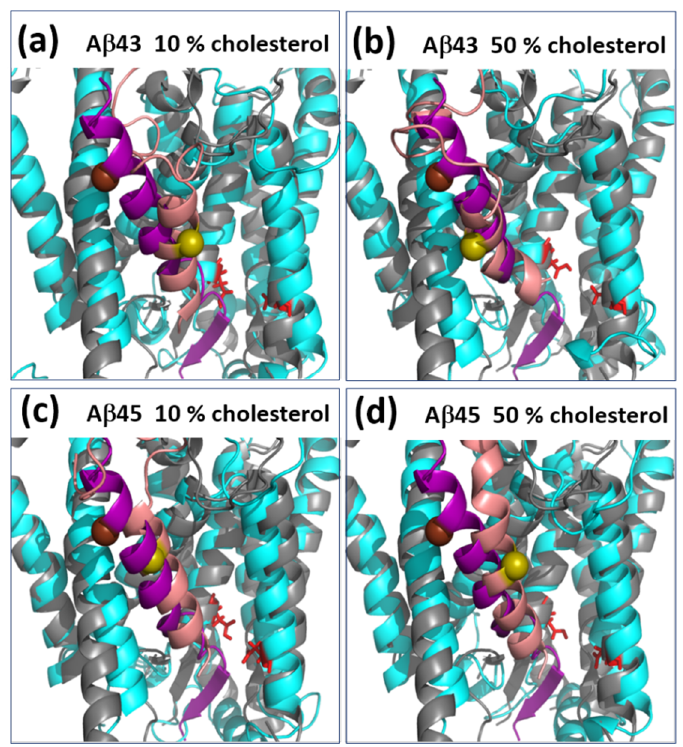
Figure 10. Comparison of cryo-EM structure (PDB id: 6IYC) with bound APP-C83 (purple helix and β-thread) with structures of Aβ peptides from exemplary MD simulations (helix in salmon). Olive and brown balls indicate the positions of the same residue to show possible rotations and movements of Aβ 43 /Aβ 45 (olive) compared with APP-C83 (brown). ( a ) Superimposition of PS-1 with APP-C83 substrate and PS-1 with docked Aβ 43 substrate after MD simulation of the γ-secretase complex in 10% cholesterol membrane; ( b ) the same in 50% cholesterol membrane; ( c ) superimposition of PS-1 with APP-C83 substrate and PS-1 with docked Aβ 45 substrate after MD simulation of the γ-secretase complex in 10% cholesterol membrane; ( d ) the same in 50% cholesterol membrane.